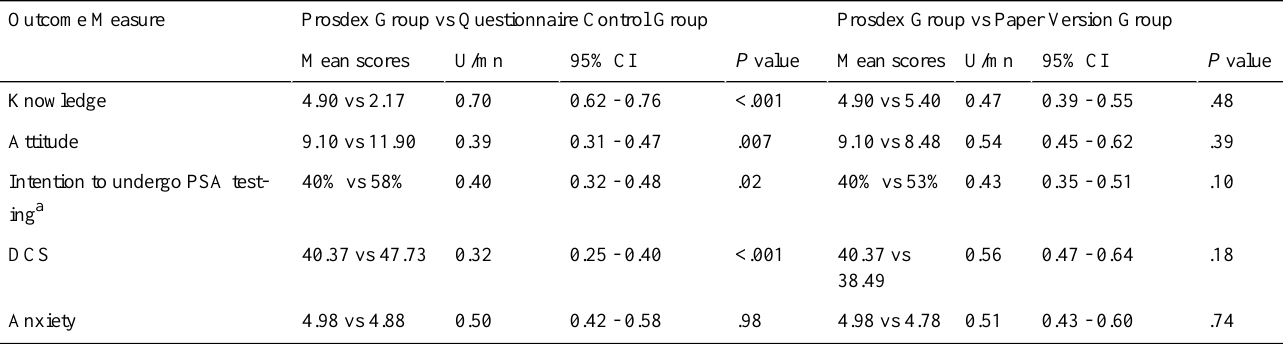
Table 2. Summary of outcome results